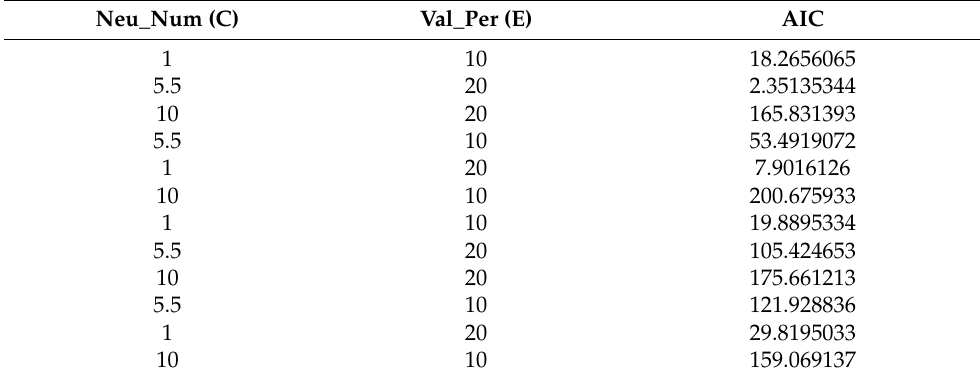
Table 9. Levels of model